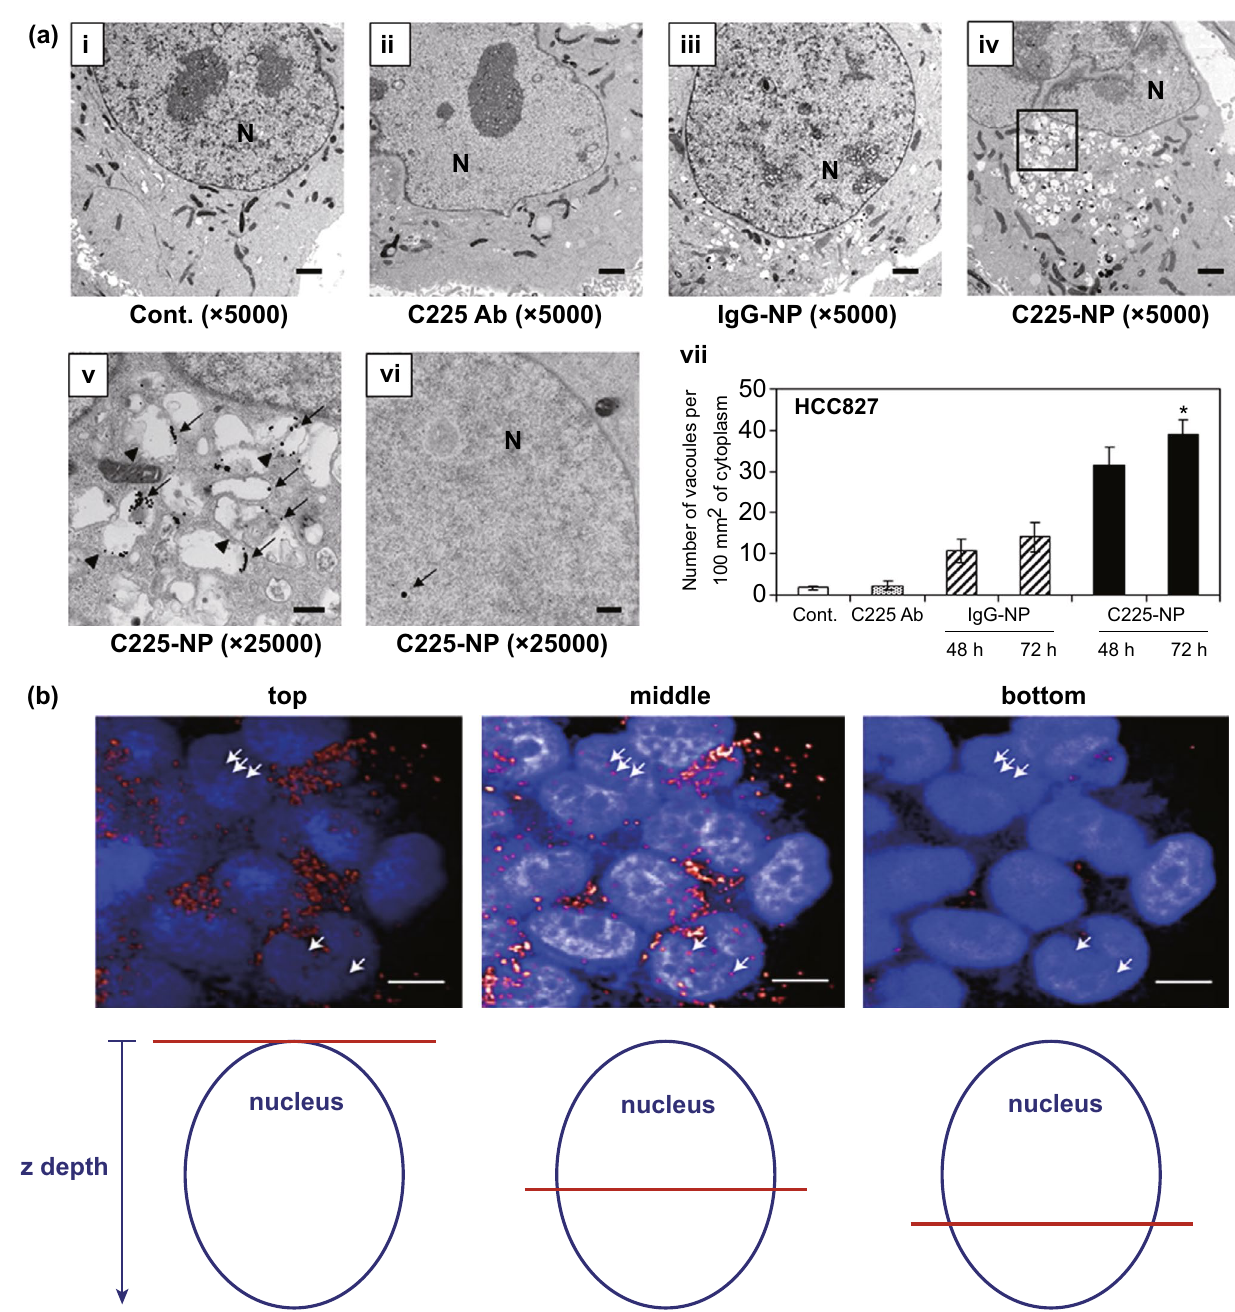
Fig. 8 a In situ localization of C225-NP in the NSCLC cells. Electron micrographs presenting the ultrastructure of a cell, including the nucleus (n), of HCC827 cells treated with 0.065 mg/ml of C225 antibody, IgG-NP, or 0.661010 particles of C225-NP for 72 h. (i) Non-treated cells, (ii) C225 antibody-treated cells, (iii) IgG-NP-treated cells, (iv) C225-NP-treated cells, (v) a magnified view of the area boxed in (iv). The arrow indicates C225-NP, and the arrowhead indicates autophagosomes of including residual material and NP in the cytosol and C225-NP inside the nucleus. Arrow indicates NP in the nucleus. Scale bar = 1 mm. (vii) number of vacuoles per μm 3 of cytoplasm after 48 and 72 h * P value, 0.05 vs control, C225 antibody and IgG-NP. b Confocal microscopy images of C225-NPs localized in the nucleus (top panel), where nuclei have been stained with DAPI dye and C225-NP localization can be marked in red. A specific area of xy plane of the nucleus at locations above or below the nucleus is denoted by the arrows indicating middle, top and bottom, respectively, whereas the Z-position of image within the nucleus is indicated by the sketch in the lower panel, wherein the red horizontal line represents the depth within nucleus from where the cross sectioning was made, Scale bar = 10 μm. Adapted from Ref. [328] under the terms of Creative Commons Attribution License as permitted by PLoS One, Copyright